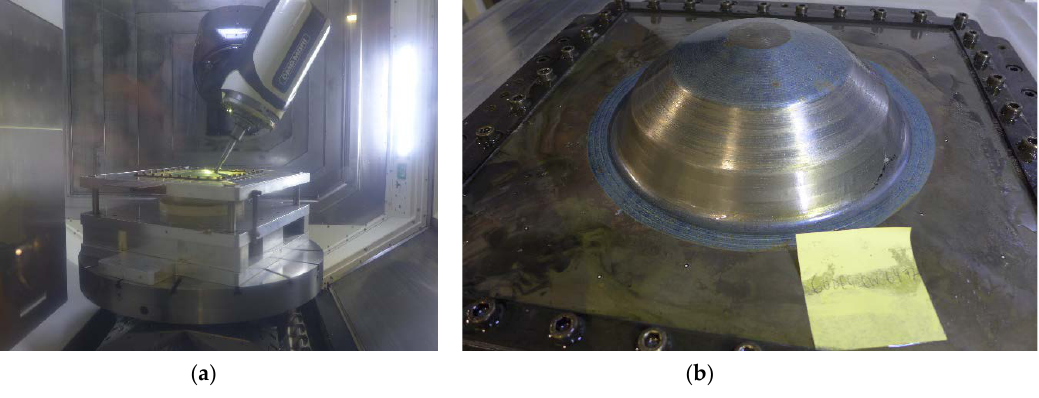
Figure 6. Performing SPIF on LMD tailored part: ( a ) Modular fixture with sheet attached during SPIF. ( b ) Final SPIF part with fracture.